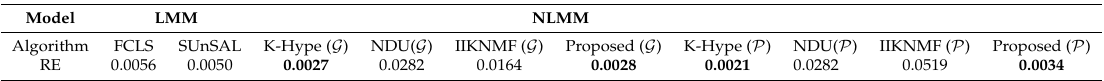
Table 4. RE comparison of S 7